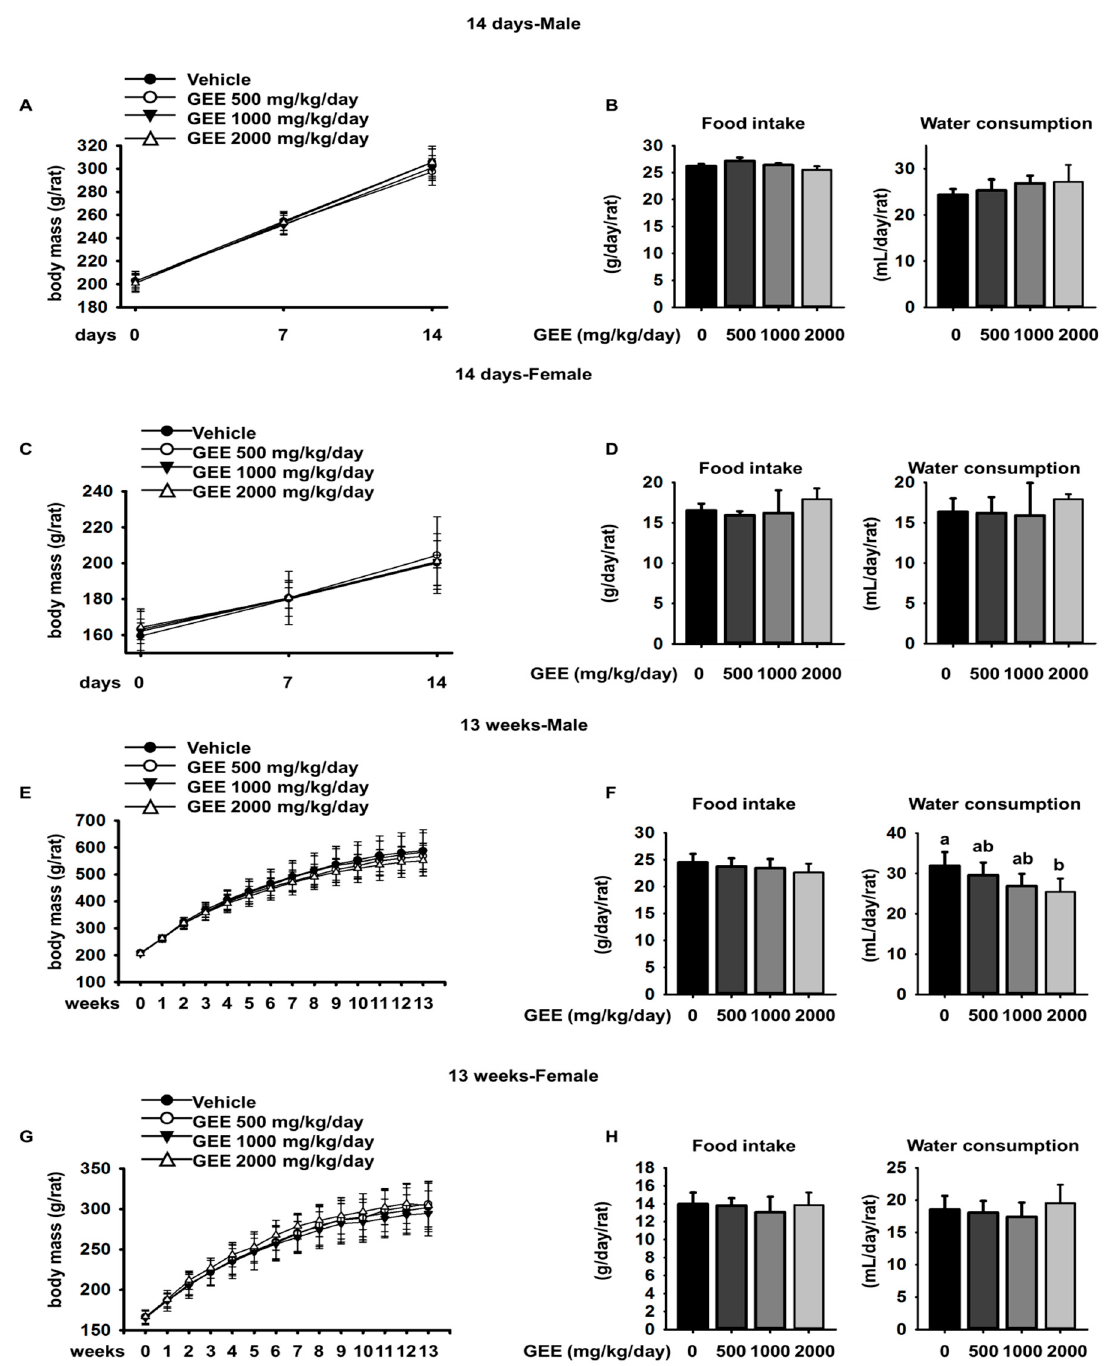
Figure 1. Effect of Gelidium elegans extract (GEE) administration on the body mass, food intake, and water consumption of rats at dosages of 500, 1000, or 2000 mg/kg/day GEE for 14 days ( A – D ) and